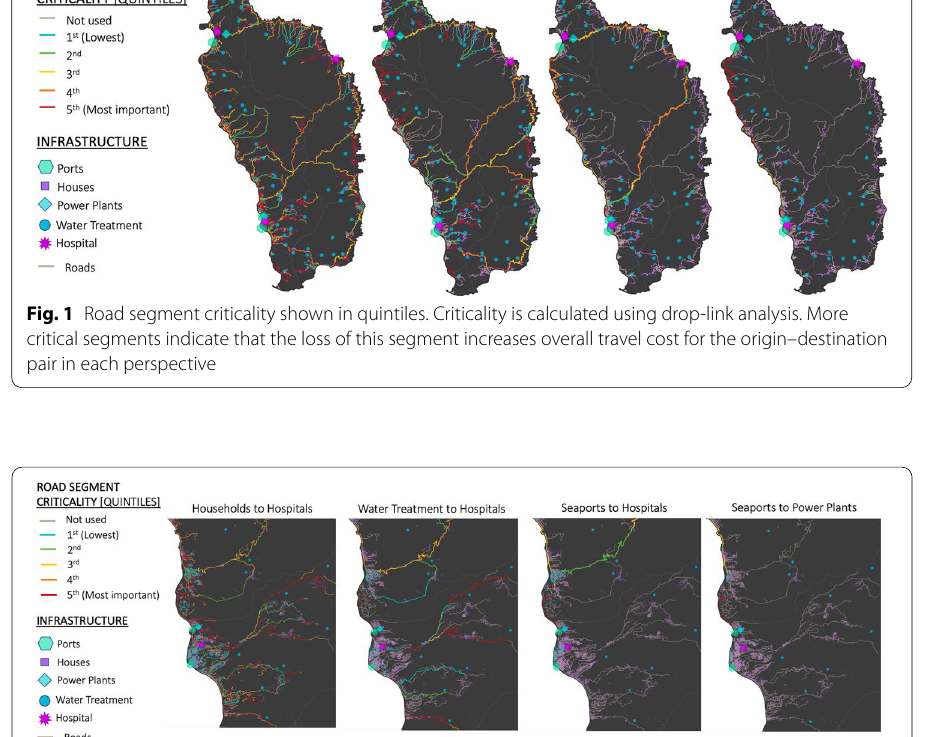
Fig. 2 Road segment criticality shown in quintiles. Criticality is calculated using drop-link analysis. More critical segments indicate that the loss of this segment increases overall travel cost for the origin–destination pair in each perspective. Results shown for Roseau